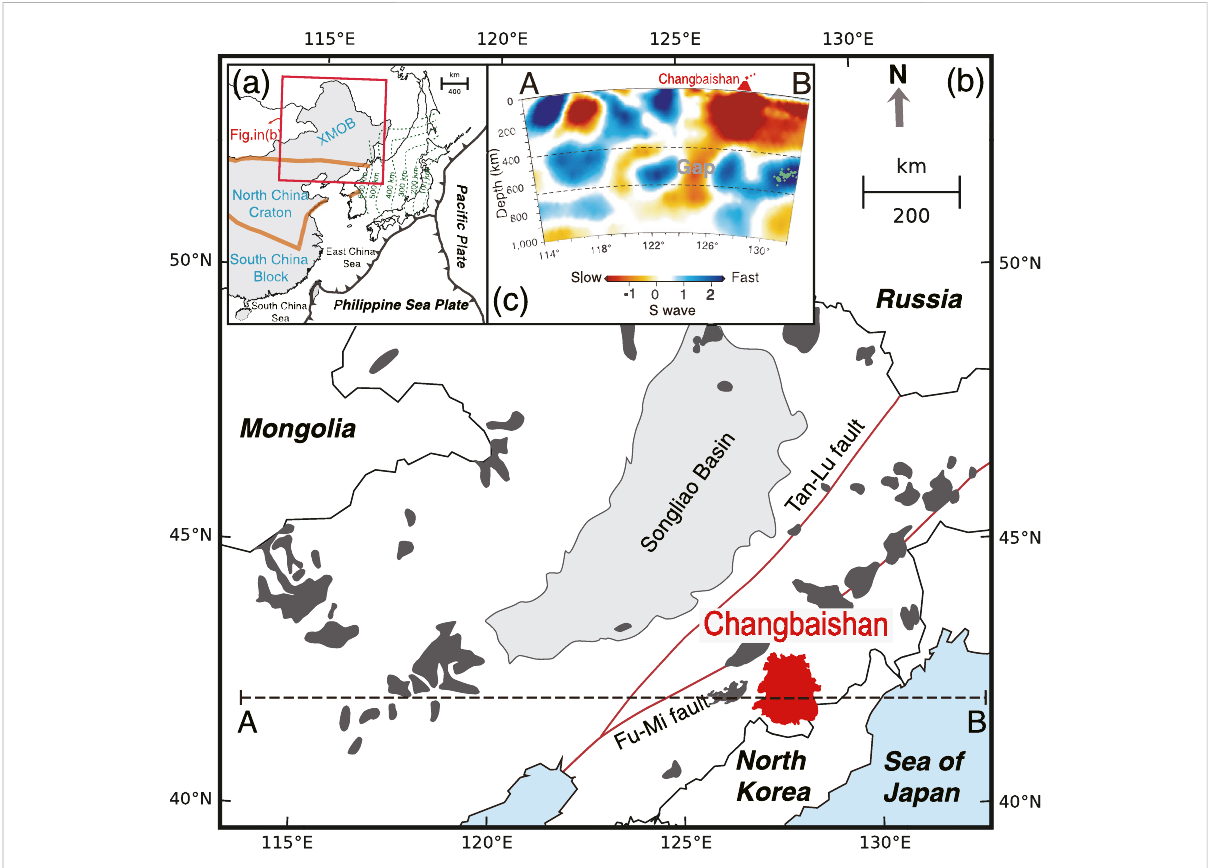
FIGURE 1 (A) Simpli fi ed geological map showing the spatial distribution of tectonic plates in East Asia. Green dashed lines indicate the Wadati-Benioff zone, showing the depths of subducted Paci fi c slab (Tang et al., 2014). (B) Distributions of Cenozoic basalts (dark grey patches, the Changbaishan volcanic fi ledwithredshadow)anddeep faults(redlines) innortheasternChinaafterLiuetal. (2001).Thedashedlineindicateslocationofthecross- section for (C) . (C) Vertical cross-sectionofS-wave velocitytomography under northeast Asia,modi fi edfromTang etal. (2014). Green dotsare deep earthquakes from 1973 to 2012. XMOB is the Xing ’ an Mongolia Orogenic Belt. (B) is an enlarged view of the red box in (A)